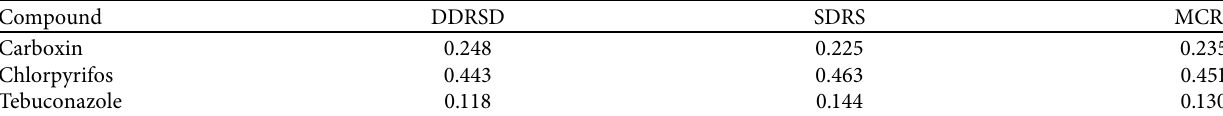
Table 5: Determination of the residues (mg/kg) of carboxin, chlorpyrifos, and tebuconazole in cabbage samples. Compound